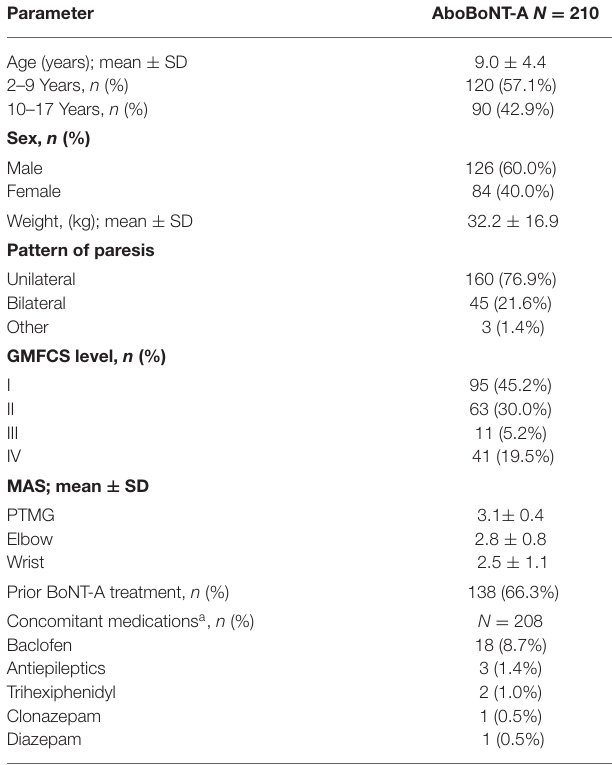
TABLE 1 | Baseline